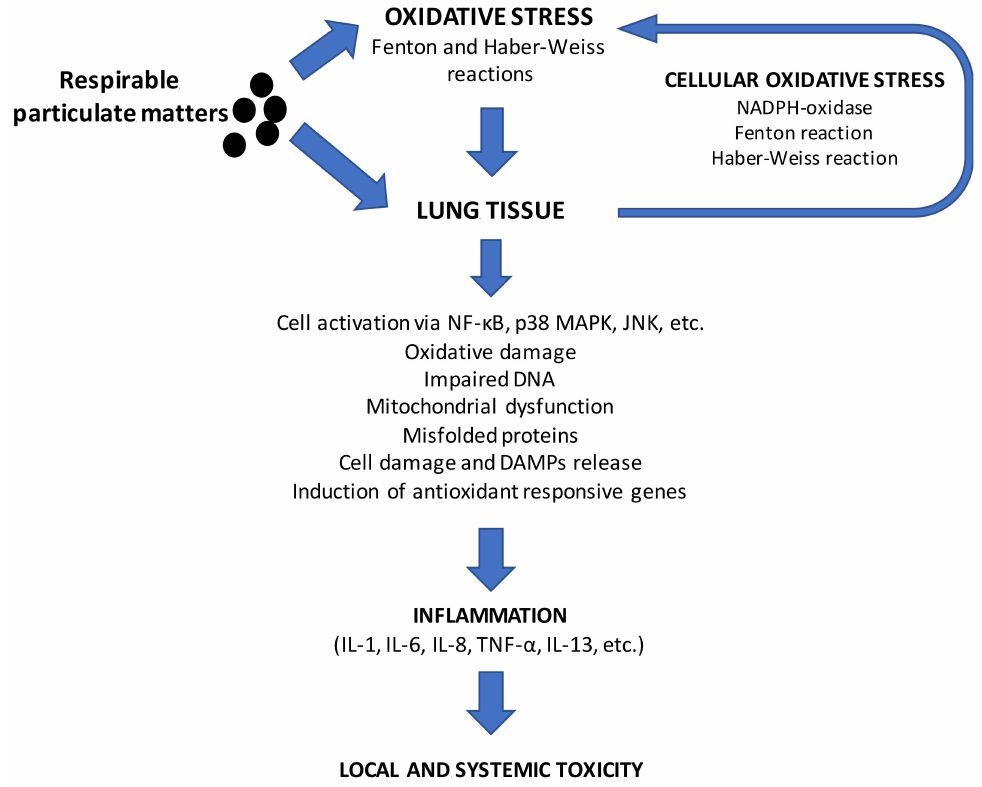
Figure 2. Biological pathways linking combustion particle-induced oxidative stress and adverse